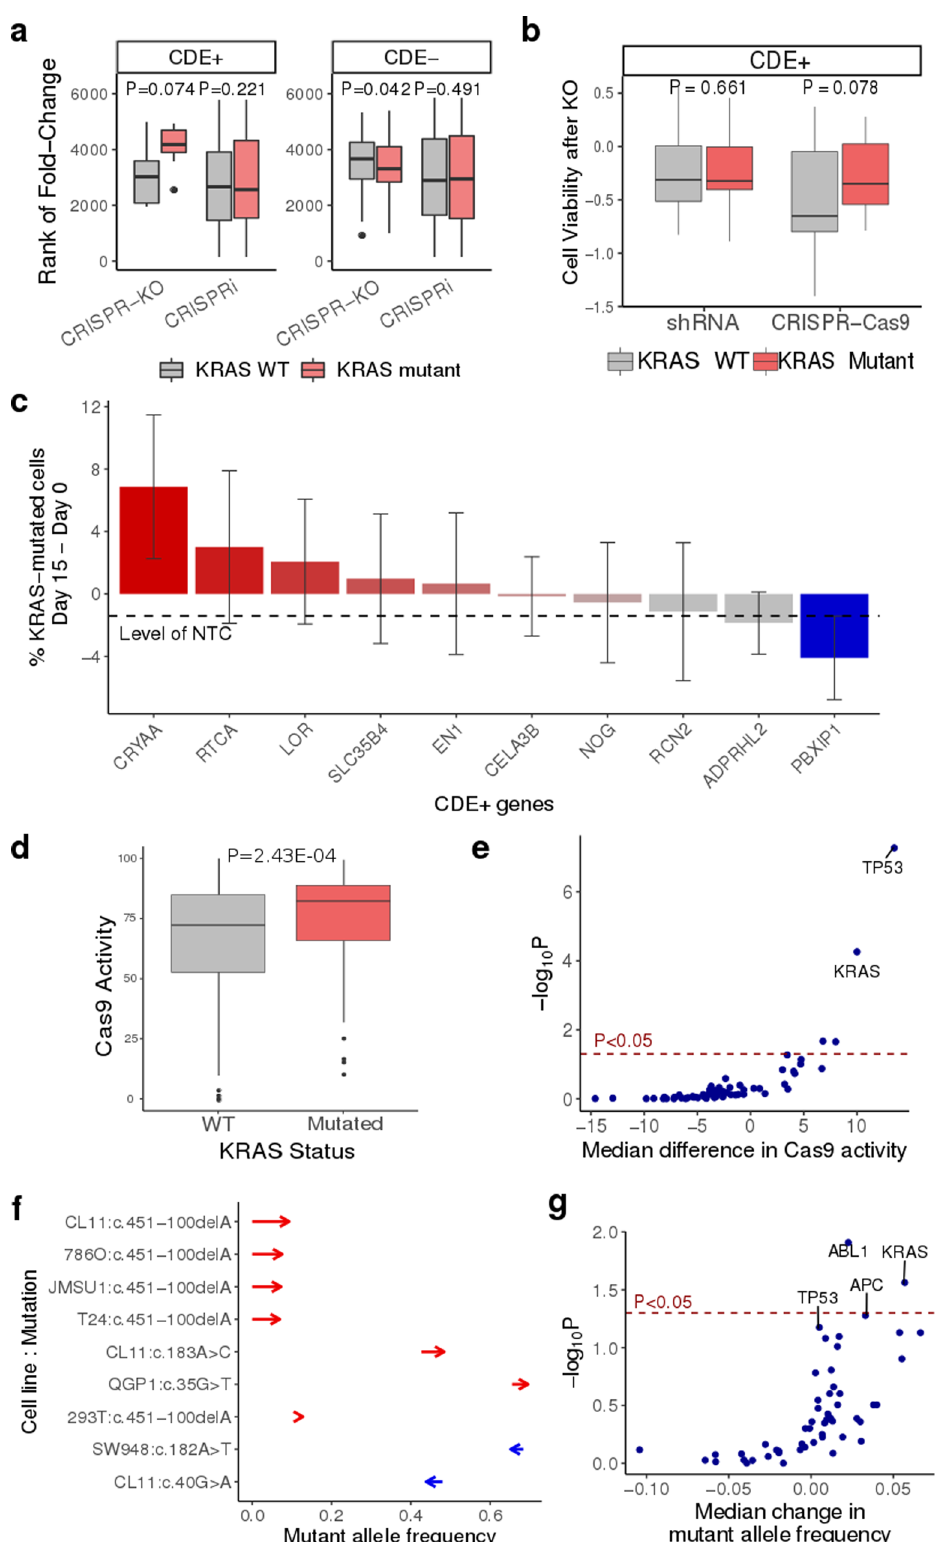
In comparison, in 8 out of 10 CDE + genes tested, there is a gain in the fi tness of the mutant cells (Fig. 6c; see the “ Methods ” section), testifying that even though the KRAS -mutant cells have a lower baseline fi tness level, the CRISPR-KO of the majority